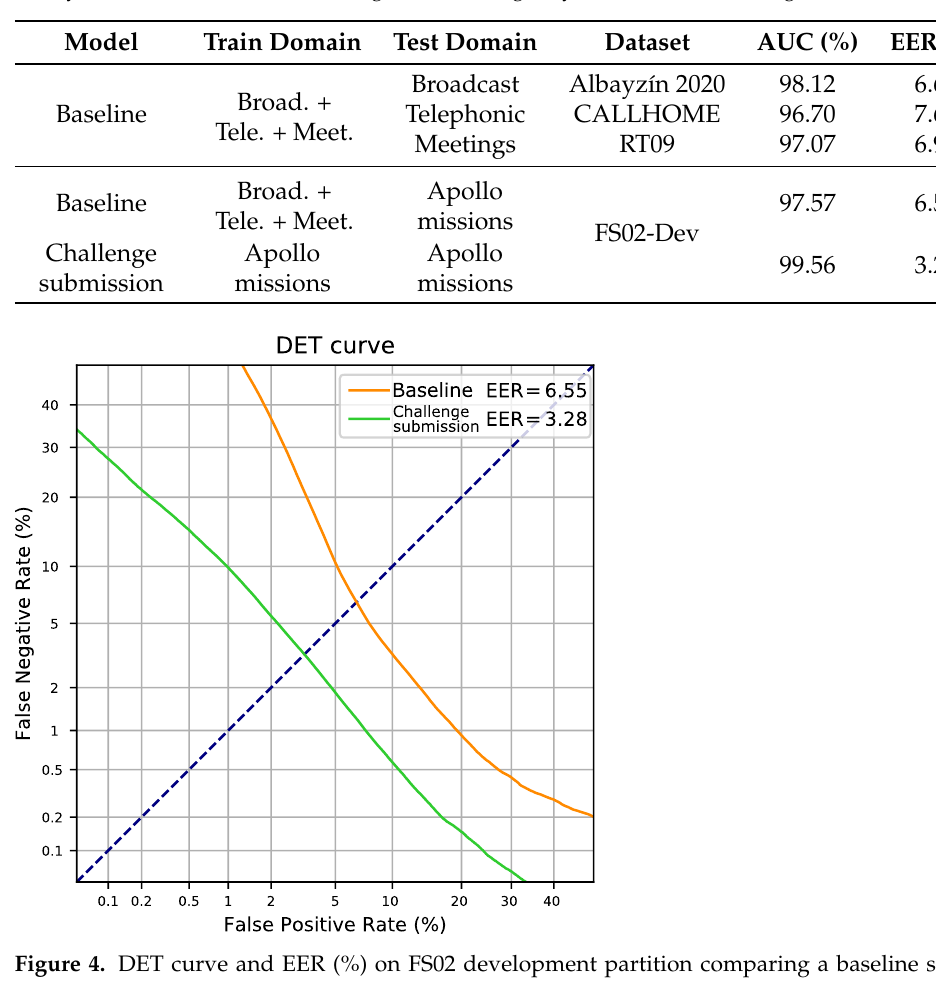
Table 2. AUC (%) and EER (%) on three in domain datasets and FS02 development partition compared to a system submitted to the challenge rained using only data from FS challenge.